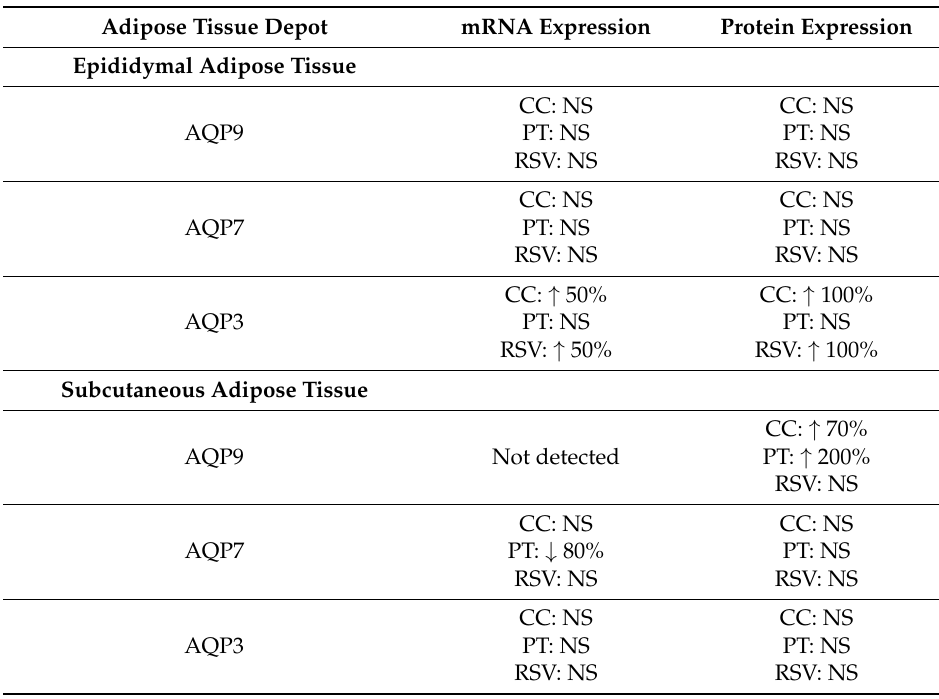
Table 1. Summary of the changes in gene and protein expressions of the analyzed aquaglyceroporins in epididymal and subcutaneous white adipose tissues and interscapular brown adipose